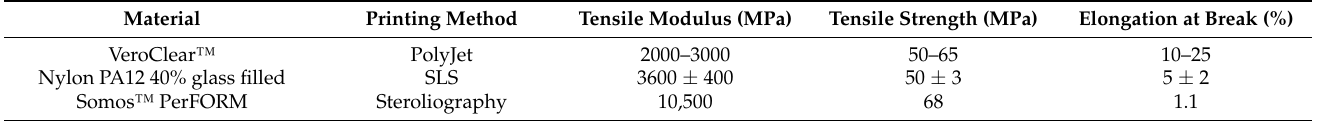
Table A1. Mechanical characteristics of the different insert materials tested (from manufactur- ers’ literature).